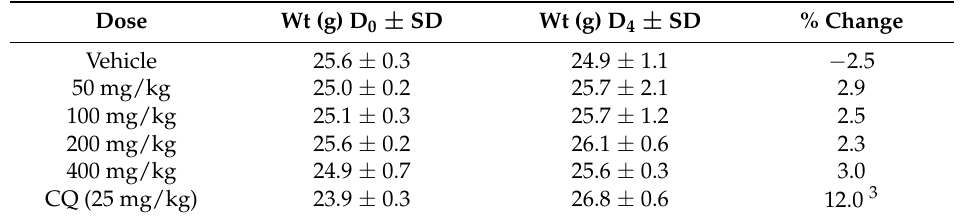
Table 2. Body weight of Plasmodium berghei- infected mice before and after administration of 80% methanol root extract of Echinops hoehnelii .